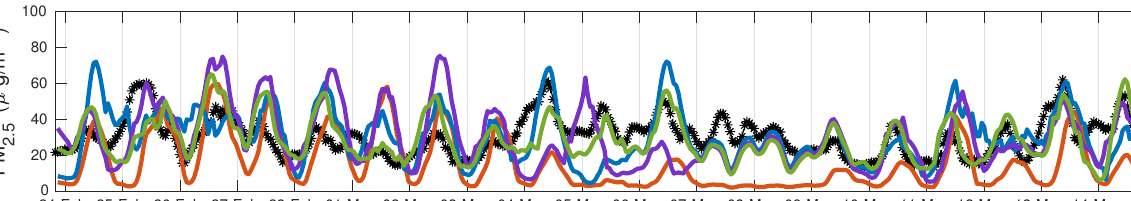
Figure 7. Temporal series of PM 2.5 concentrations from selected validation stations of the official network ( a – d ), LOTOS- EUROS without assimilation, LE-official, LE-lowcost and LE-lowcost-HQ. Time stamps are valid for local time (UTC-5). A spin-up period consisting of the 5 days prior to the start date was used for each